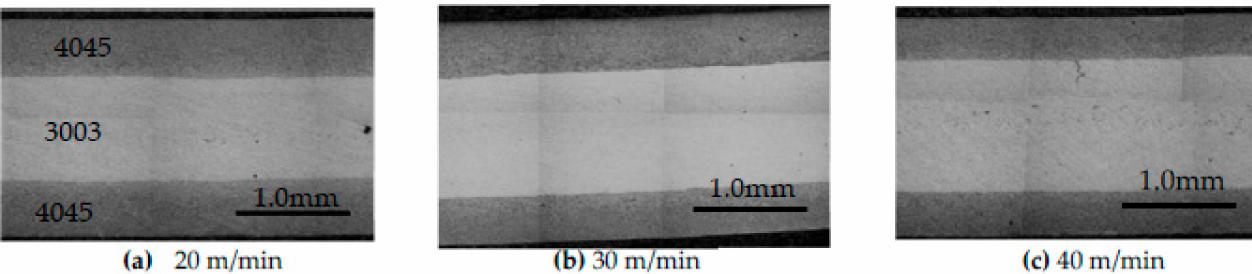
Figure 7. Cross-sections of cold rolled clad strips cast at different roll speeds. Base strip is 3003 and over lay strip is 4045. Roll speed: ( a ) 20 m/min, ( b ) 30 m/min, ( c ) 40 m/min.